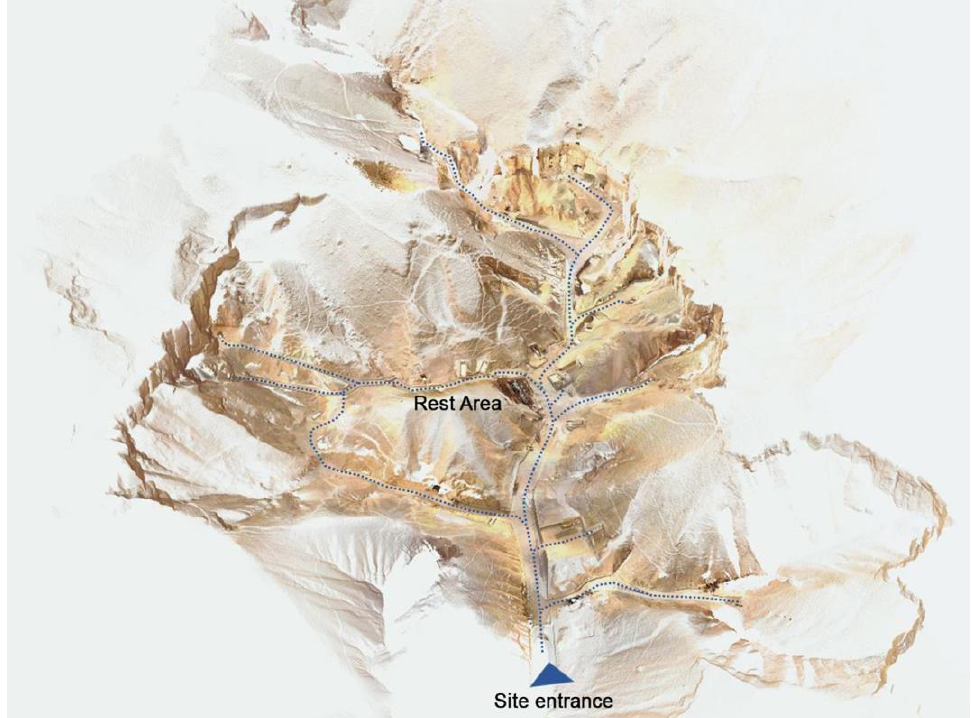
Figure 3. Image of the resulting merged point clouds (102 single scans) with more than 2 billion of points, and with superimposed visiting paths (open and closed).